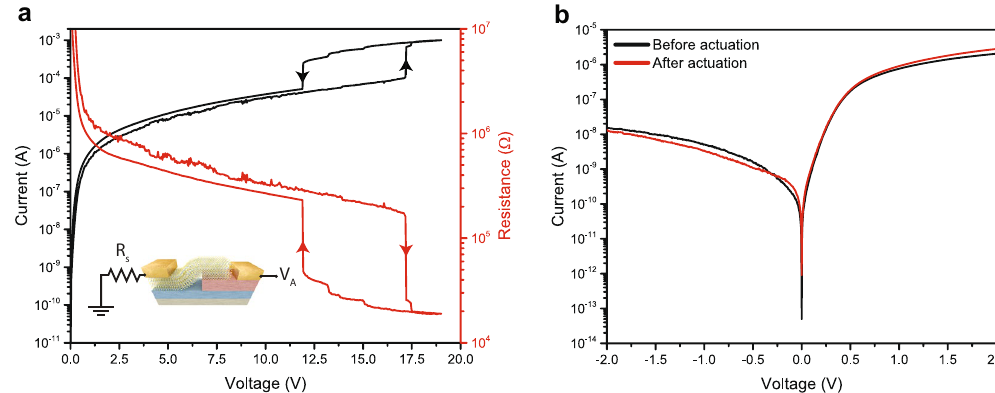
Figure 3. Electrically induced IMT of the VO 2 side of the heterojunction. ( a ) Electrical characteristic of device D2 under large applied bias, sufficient to trigger the IMT of VO 2 close to 17.5 V. Inset: biasing scheme used for the experiment. A discrete resistor R S of 1 kΩ is connected in series to the device to limit the current in the low resistance state. ( b ) I–V curve of D2 measured before and after having electrically induced the IMT of VO 2 . The comparison between the two curves shows that the phase change of VO 2 and the actuation power has no permanent effect on the electrical behavior of the